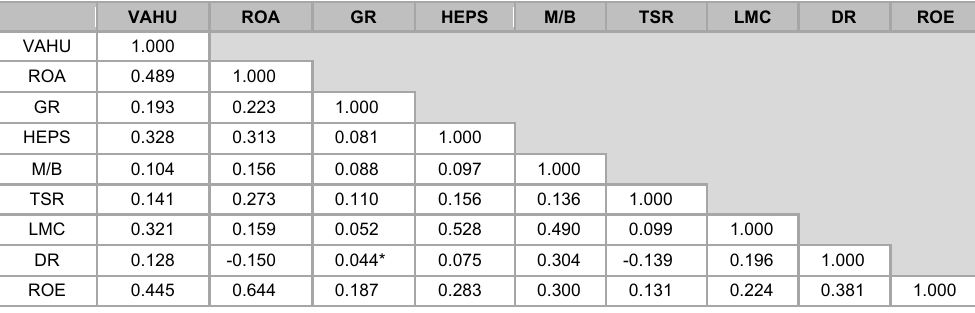
Correlation matrix for the regression